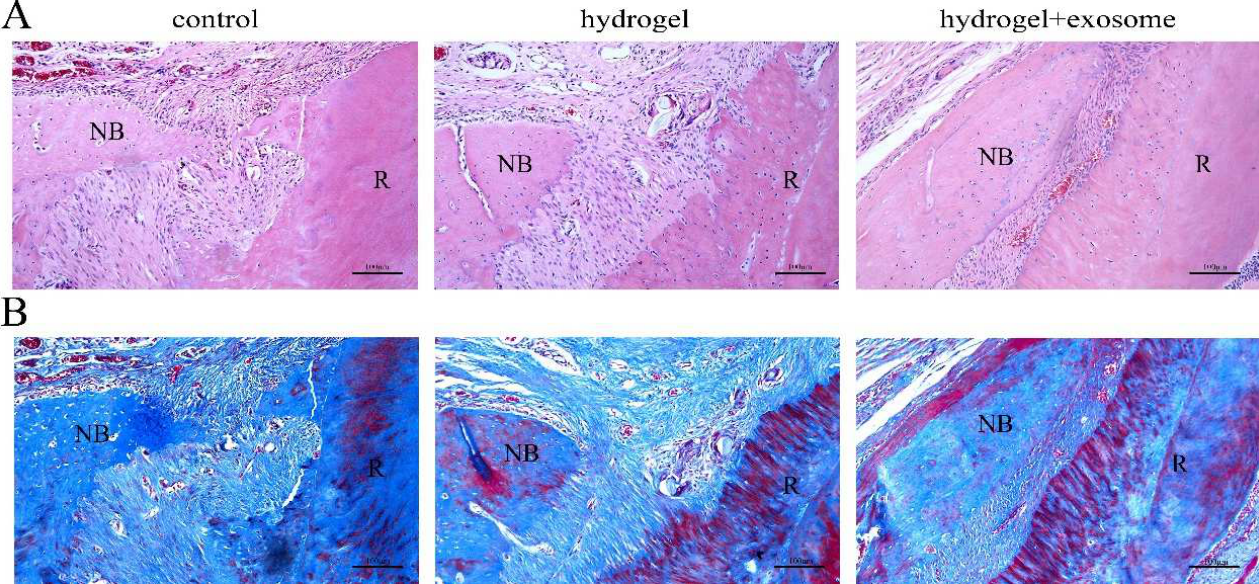
Figure 5. Micro-CT assessment of bone formation at 4 weeks post-surgery ( A ) representative micro- CT images for the different groups at the defect site (indicated by the yellow arrowheads) ( B ) BV/TV; (*), p < 0.05 compared to the control group; (**), p < 0.05 compared to the hydrogel group.